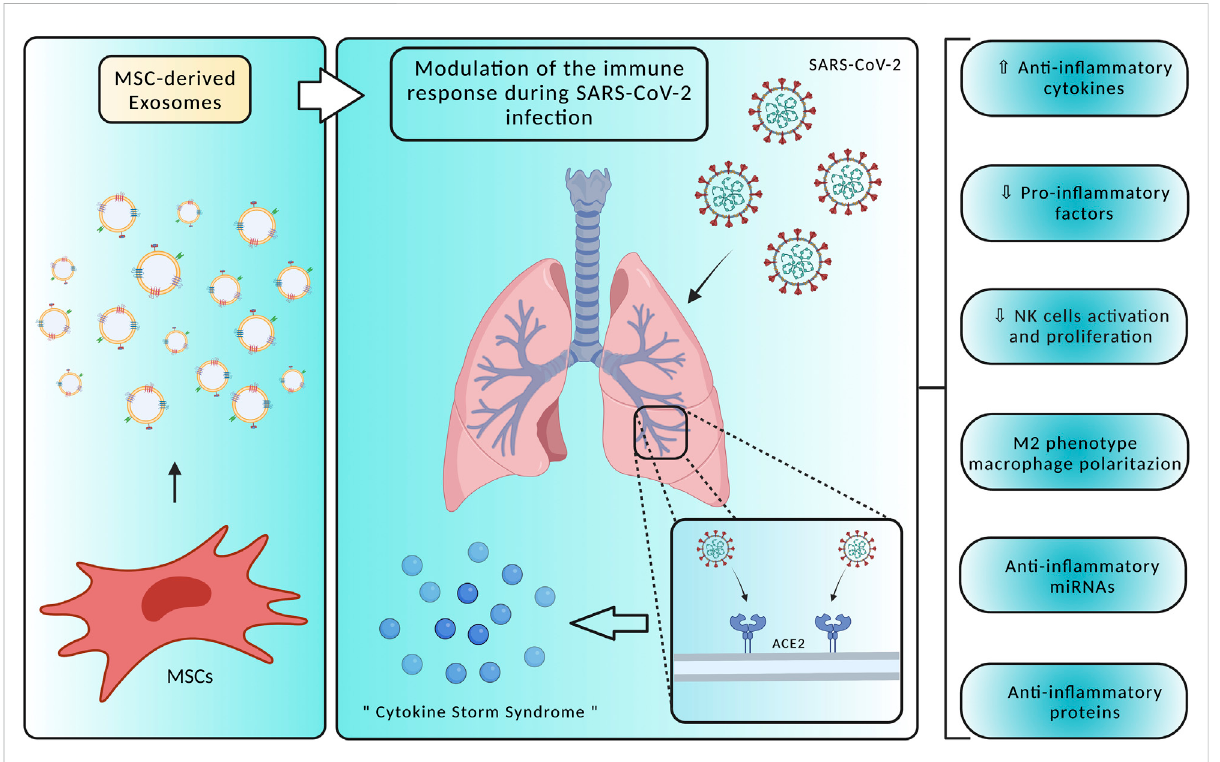
FIGURE 2 Mesenchymal Stem Cells (MSC)-derived exosomes display several mechanisms of action in counteracting SARS-CoV-2 infection, modulating thehostimmuneresponsesandactingonthe “ cytokinestormsyndrome ” .Speci fi cally,treatmentwithMSC-derivedexosomesmaypromoteananti- in fl ammatory environment by reducing pro-in fl ammatory factors and NK cells activation, producing anti-in fl ammatory factors, and polarizing macrophages towards an M2 phenotype. Created with